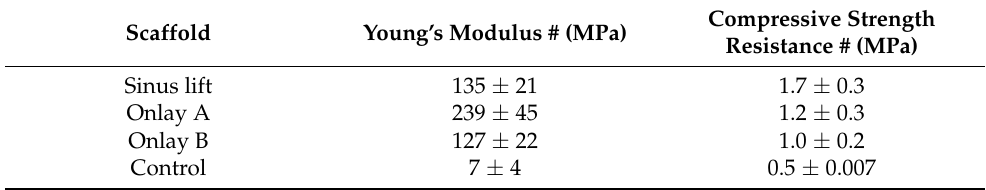
Table 3. Mechanical properties of patient individual scaffolds and control group.